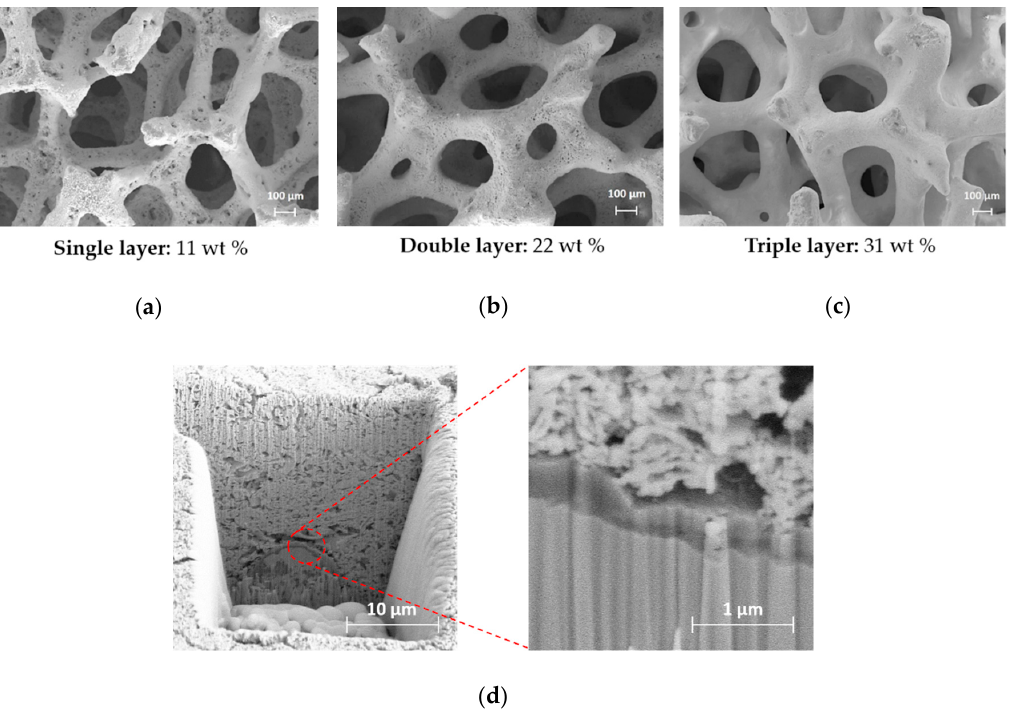
Figure 3. SEM micrographs of structured catalysts coated with ( a ) single-layer, ( b ) double-layer ( c ) and